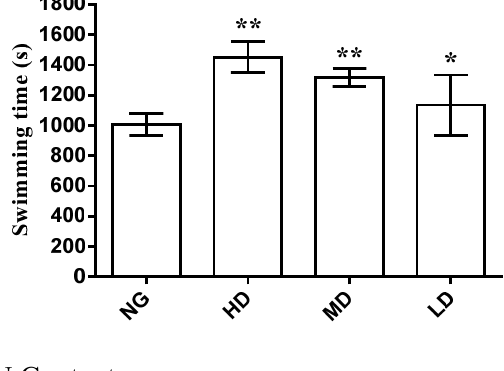
Figure 3. Effect of the phenolic extract on the swimming time in mice. Results are expressed as a mean ± SD (n = 10). * p < 0.05, ** p < 0.01 compared with the normal group (NG). HD: High-dose extract treated group; MD: Middle-dose extract treated group; LD: Low-dose extract treated